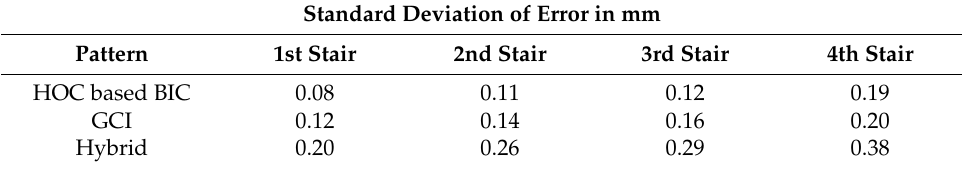
Table 2. Accuracy measurement for different structured light patterns at a 100 cm distance from the camera to the object.